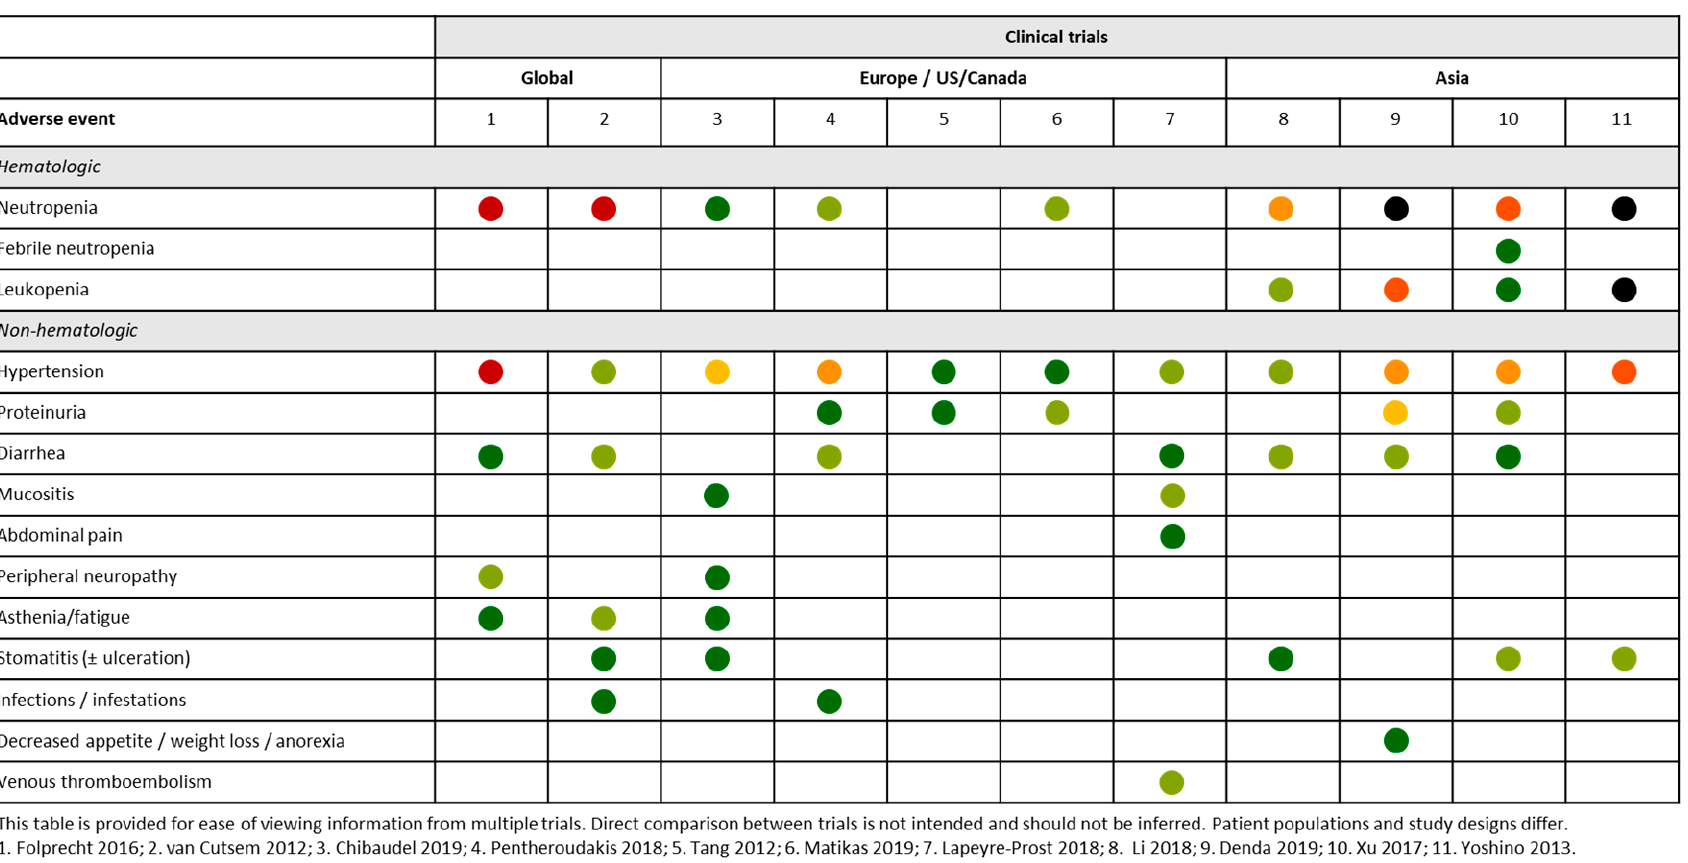
Figure 3. Summary of Grade ≥ 3 adverse events occurring in ≥ 10% of patients across clinical trials of aflibercept in patients with mCRC.